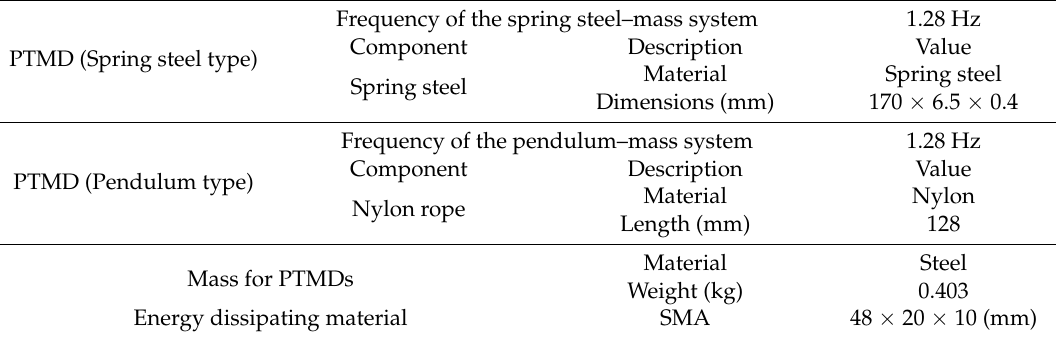
Figure 5. ( a ) Control device installed at the piping system; ( b ) spring steel type SMA–PTMD; ( c ) pendulum type SMA–PTMD. Table 1. Parameters of PTMDs (pounding tuned mass dampers). Table 1. Parameters of PTMDs (pounding tuned mass